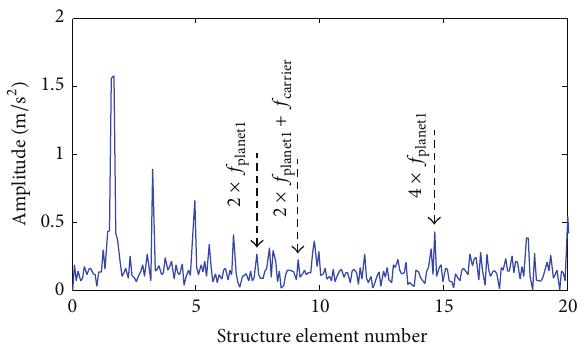
Figure 31: Frequency spectrum of filtered